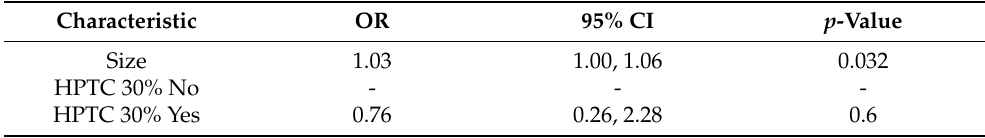
Table 2. Multivariable analysis for the outcome mortality. Two parameters (i.e., size and HPTC %) were selected, due to the number of deaths of 29, considering 10 events per parameter. OR: odds ratio, CI: confidence interval, HPTC: hobnail papillary thyroid carcinoma. Characteristic OR 95% CI p -Value Size 1.03 1.00, 1.06 0.032 HPTC 30% No - - - HPTC 30% Yes 0.76 0.26, 2.28